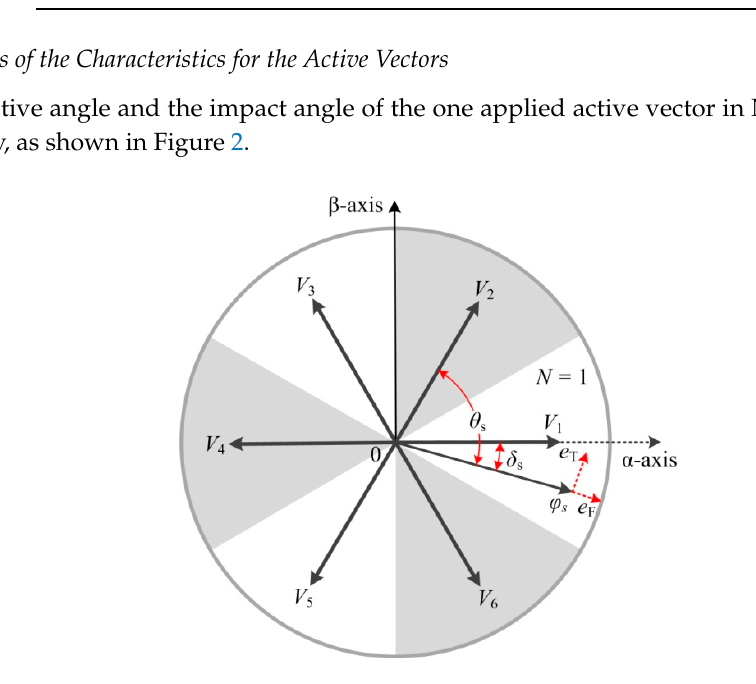
Figure 2. Relationships of the variables in the control system.